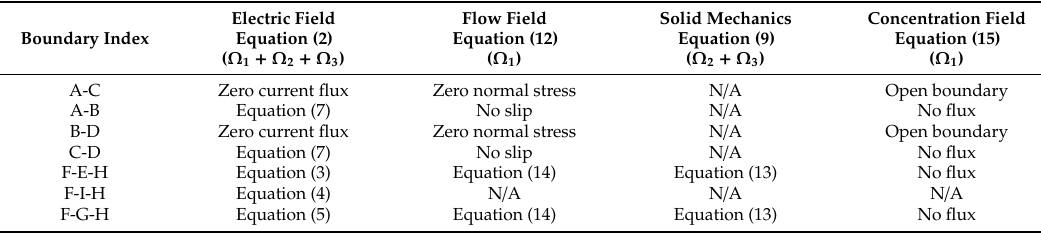
Table 2. Boundary conditions for the simulation domain shown in Figure 1d implemented in Comsol